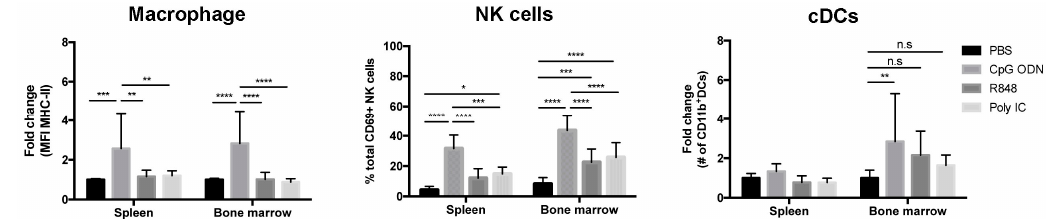
Figure 3. CpG ODN is sufficient to exert immunomodulatory effects in mice bearing B-ALL. Three days after a single-dose of endosomal TLR agonist, the percentage or number of activated innate immune cells in spleens and bone marrow of wt BALB/c mice bearing primary E μ -ret B-ALL cells were measured. Graphs depict the fold change in the expression levels of MHC class II on macrophages (left panel), the percentage of activated NK cells among total viable NK cells (middle panel), and the fold change in the absolute number of CD11b + cDCs (right panel). Results shown are pooled from four independent experiments: PBS-treated mice (n = 15); CpG ODN-treated mice (n = 14); R848-treated mice (n = 15); polyI:C-treated mice (n = 17). Dunn’s multiple comparisons tests, bars represent mean ± S.D.; * p < 0.05, ** p < 0.01, *** p < 0.001, **** p < 0.0001. n.s = not significant.